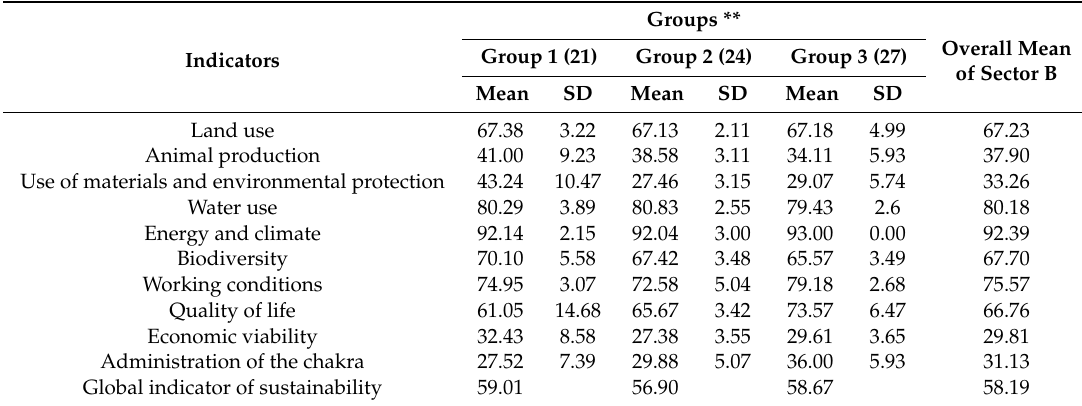
Table 5. Means and SDs of sustainability indicators among clusters (groups) of the chakra systems in sector B in the north of the Yasun í Biosphere Reserve in the Ecuadorian Amazon region.